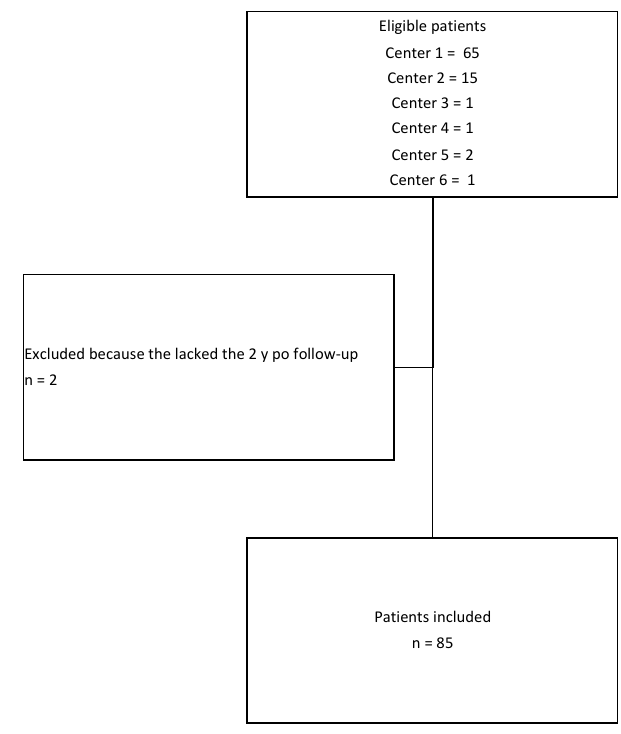
Figure 3. Flowchart of the study. The baseline characteristics of the patients in the series are described in Table 1. Table 1. Summary of patients’ characteristics. Continuous data are presented as mean (standard deviation).